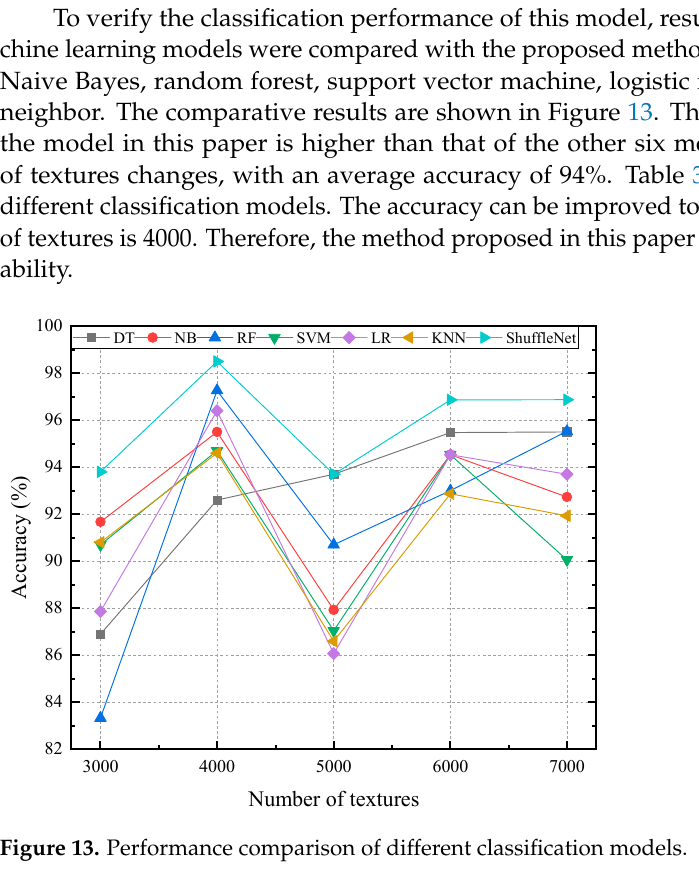
Table 3. The results of different classification models.